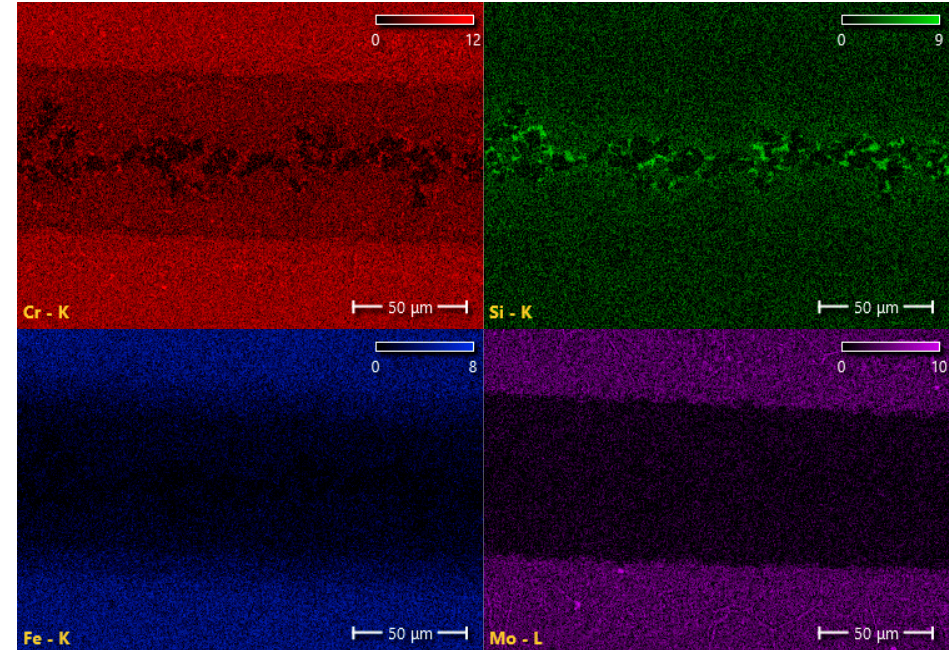
Figure 6. Hastelloy X–Palnicro 36M joint obtained after 30 min brazing at 995 °C: SEM micrograph and EDS maps of elements’ distribution.